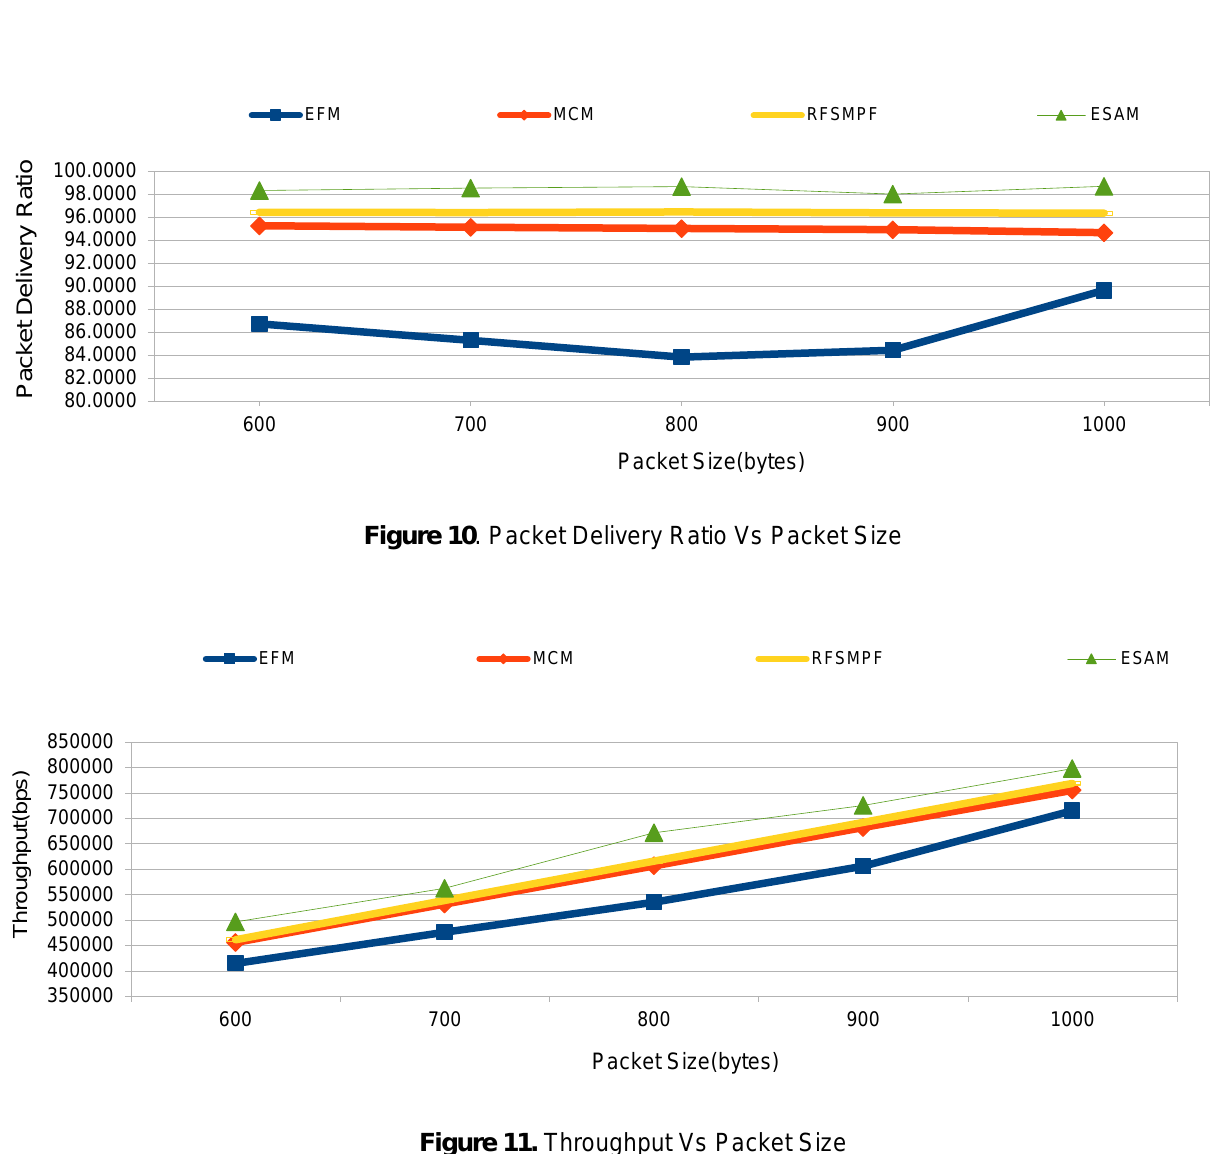
Figure 11. Throughput Vs Packet